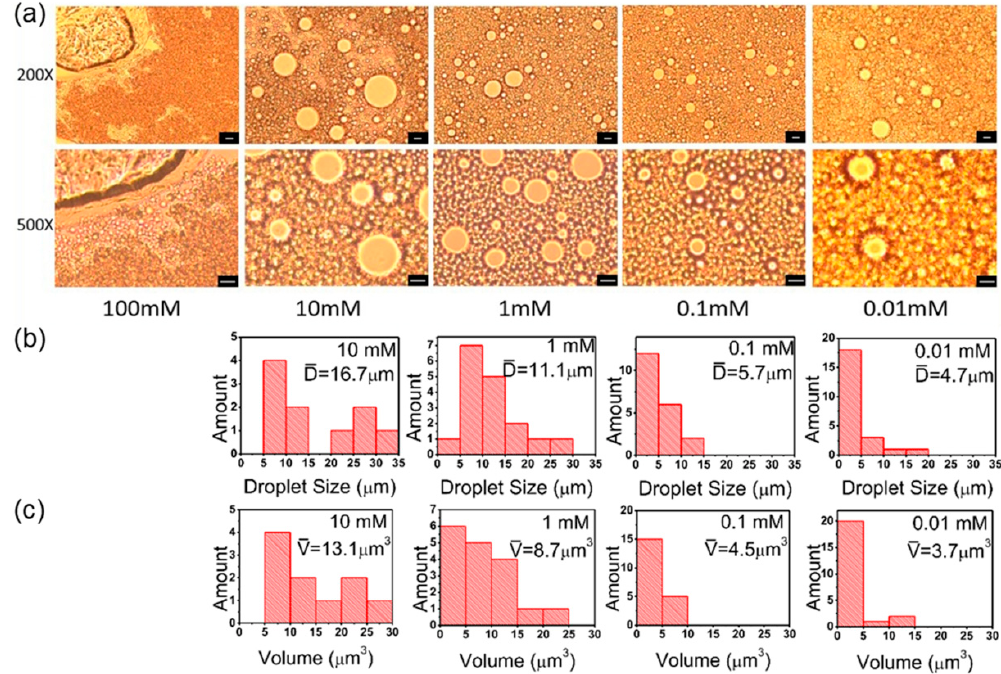
Figure 7. ( a ) Microscope images of hexadecane/H 2 O Pickering emulsions stabilized by PS@PSS under different salt concentrations. Here the ultrasonic power is 150 W, water:oil ratio is 1:1, and ultrasonic time is 3 min. The bar is 10 µ m. ( b ) Particle size distribution in number corresponding to microscope images. ( c ) Droplets volume distribution corresponding to microscope